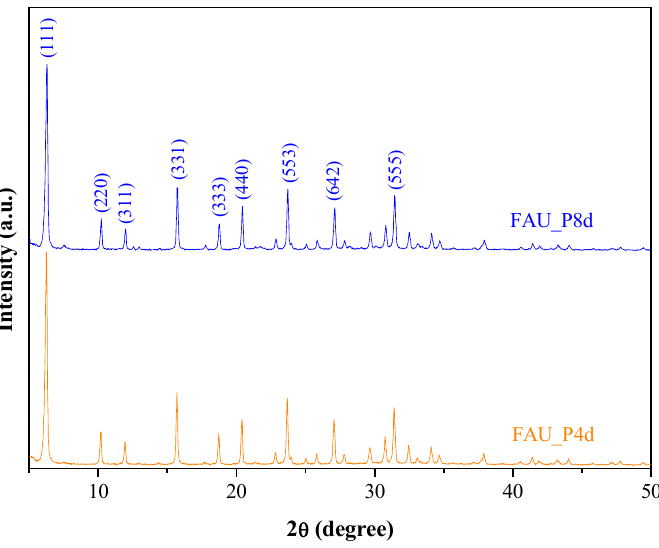
Figure 1. Standard LTA zeolite diffractograms.